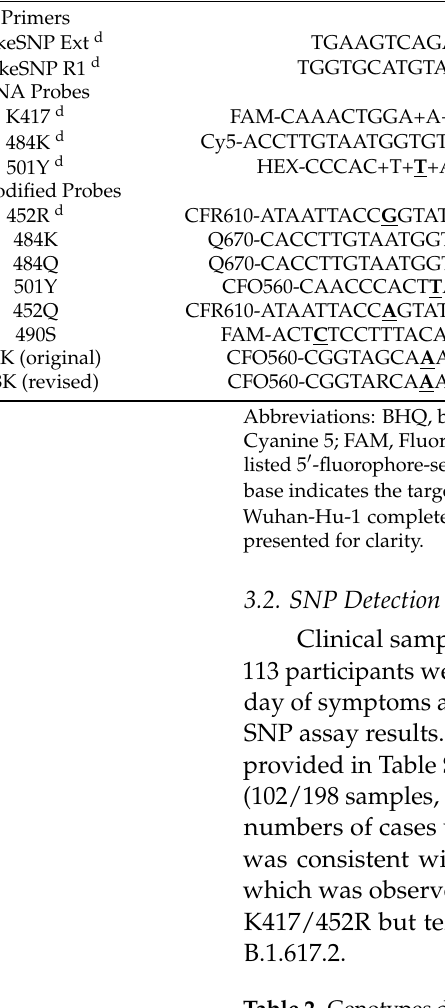
Table 2. Genotypes detected in the Spike SNP assay, patient demographics, and the percent confirmed using amplicon